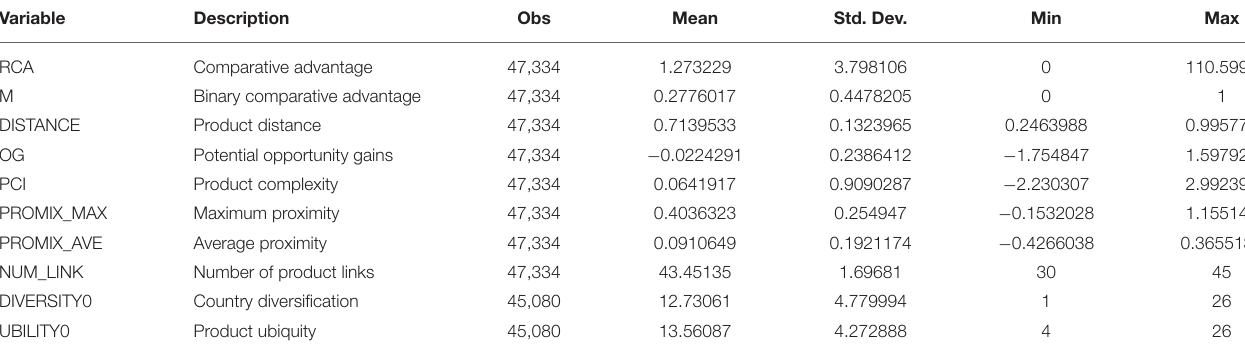
TABLE 1 | Descriptive statistics of each variable. Variable